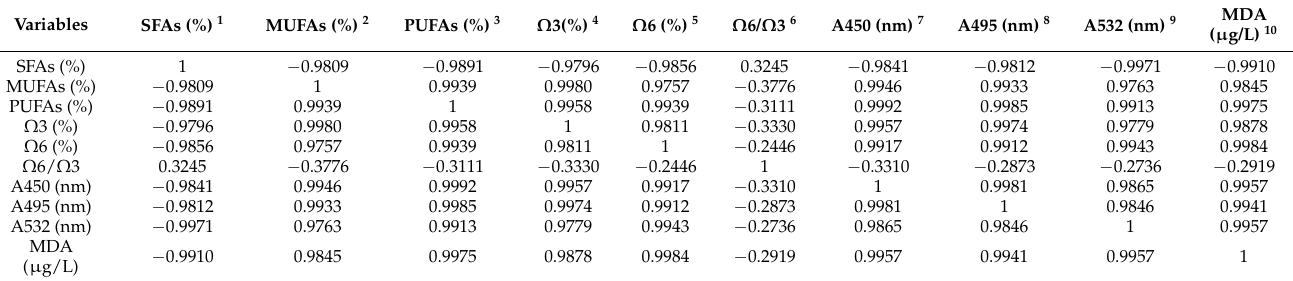
Figure 2. Degradation yield (%) expressed after 24 h storage at room temperature, for each type of milk, measured for each degradation parameter considered. Table 6. Correlation matrix describing the interrelation between quality of lipids and oxidation pa ‐ rameters.